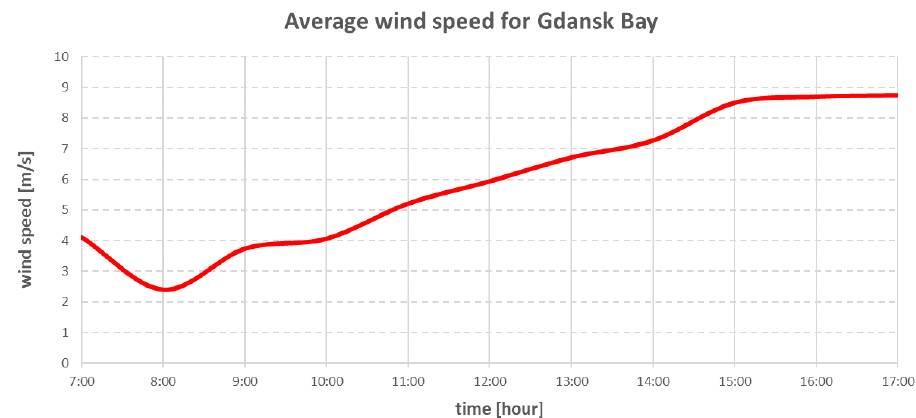
Figure 7. Averaged wind speed changes in Gdansk Bay on 19 May 2022.